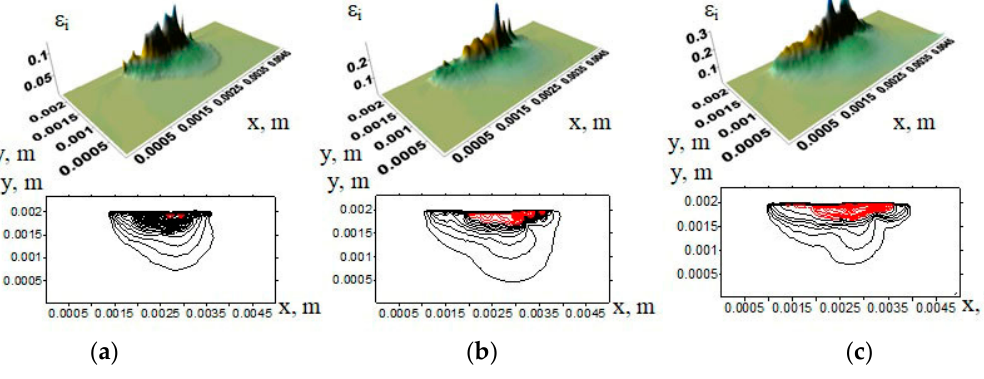
Figure 4. Strain distribution surfaces and their corresponding contours in UHMWPE samples under applying normal and tangential loads at maximum strain intensity: ( a ) 10%; ( b ) 20%; ( c ) 30%.